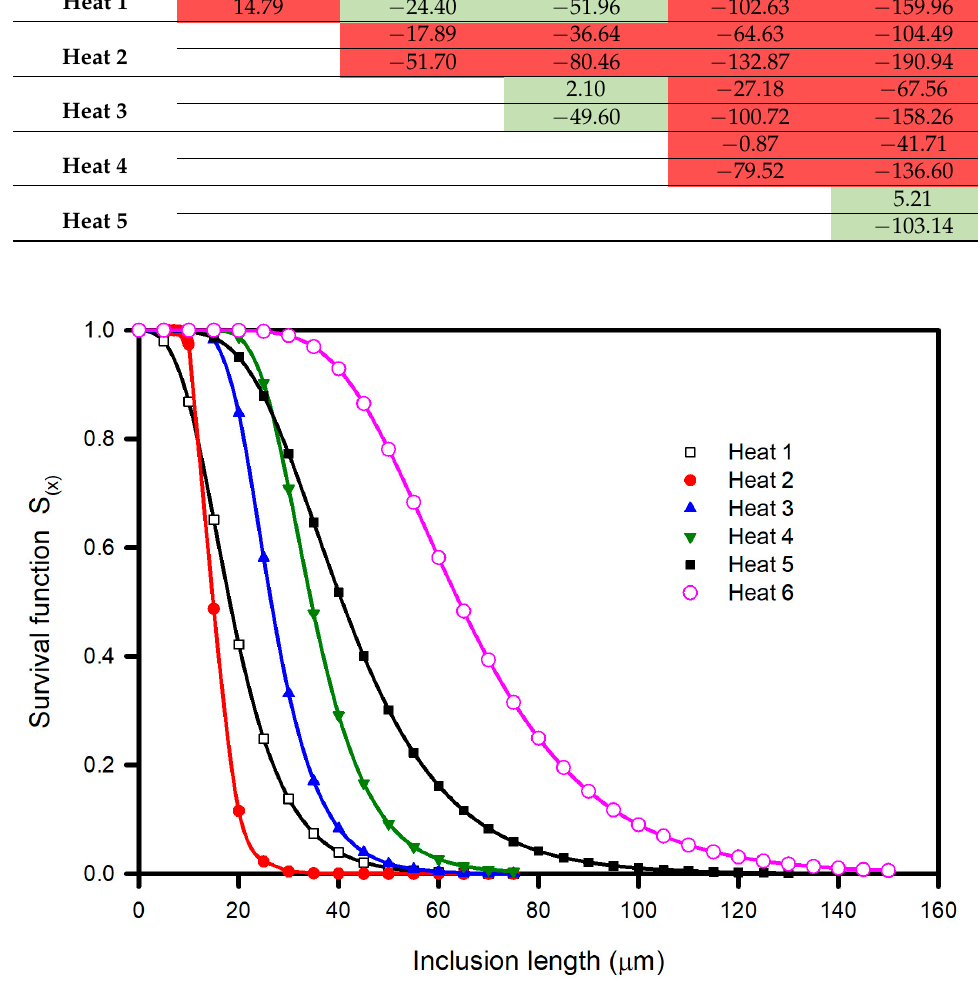
Figure 13. Survival function S (x) for each heat. S (x) is plotted in Figure 14 from the data of Figure 13 for three critical inclusion lengths: 10, 20 and 30 µ m. The heats can be ordered by increasing the S (x) value for each critical value; for example, for an inclusion length shorter than 10 µ m, the order is Heat 1, Heat 2, Heat 3, Heat 4, Heat 5 and Heat 6. This order is altered when the critical value of 20 µ m is selected, changing the order to Heat 2, Heat 1, Heat 3, Heat 5, Heat 4 and Heat 6. The observed difference is explained by the overlapping probability density curves and S (x) curves for Heats 1 and 2 and for Heats 4 and 5. For example, in Heat 1 and Heat 2, overlapping can be observed in the upper left corner in Figure 13, or the overlapping of probability density functions in the lower left corner in Figure 11. The same explanation can be used for the inversion of order between Heats 4 and 5. Furthermore, for critical values greater than 35 µ m, where no overlapping of curves is observed, the order is Heat 2, Heat 1, Heat 3, Heat 4, Heat 5 and Heat 6. This is the same when parameter L max is considered as the cleanliness